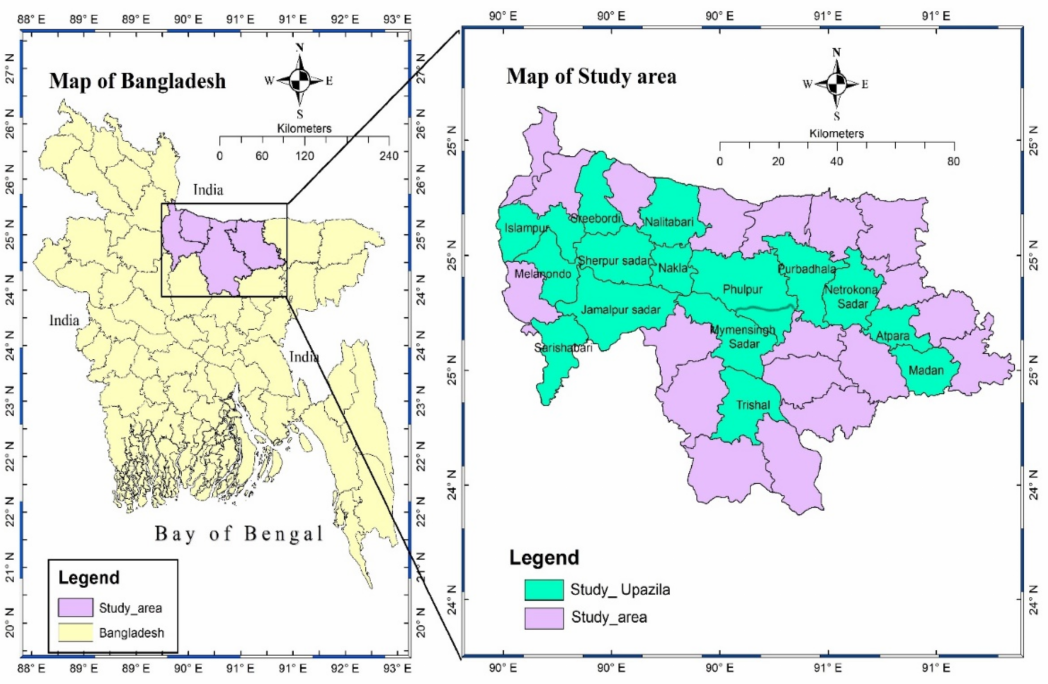
Figure 5. Maps of study area. Bangladesh is the country; Study_area means the Mymensingh division of Bangladesh; Study_Upazilla means the selected 16 upazillas within Mymensingh division of